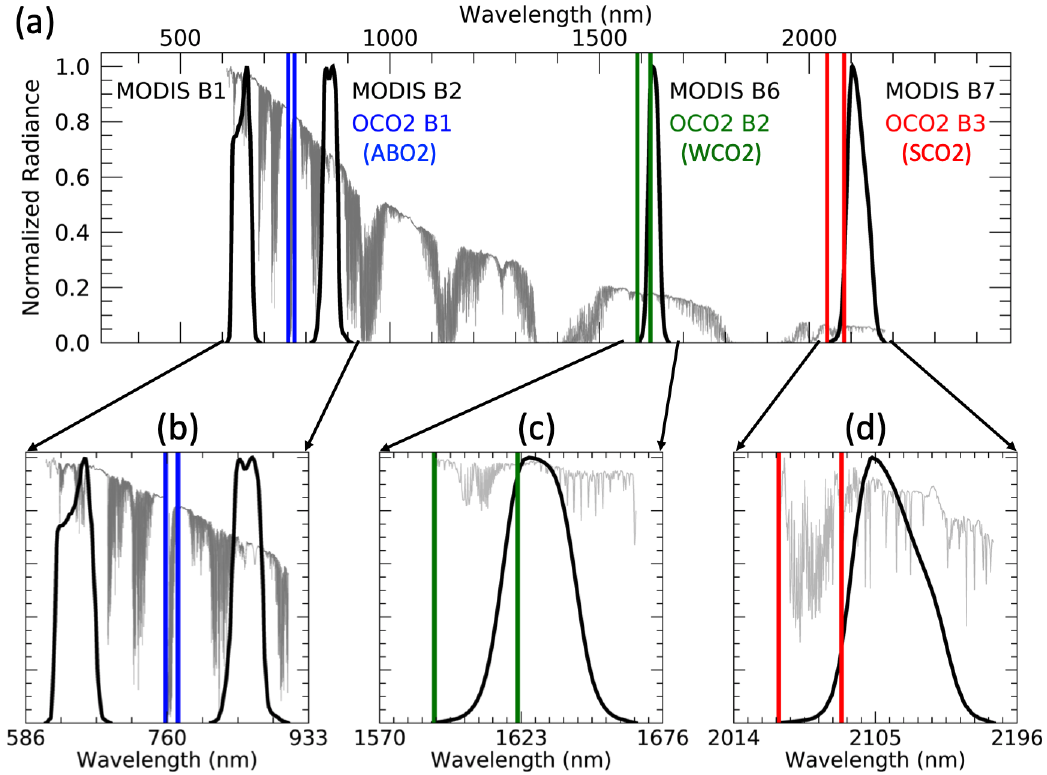
Figure 2. Wavelength ranges measured by OCO-2 overlaid with the relative spectral response functions of MODIS Bands 1, 2, 6 and 7, along with Top of Atmosphere radiance simulated with MODTRAN: Panel ( a ) for overview from 500–2300 nm,; Panel ( b ) for expanded view around 760 nm; Panel ( c ) for expanded view around 1623 nm; Panel ( d ) for expanded view around 2105